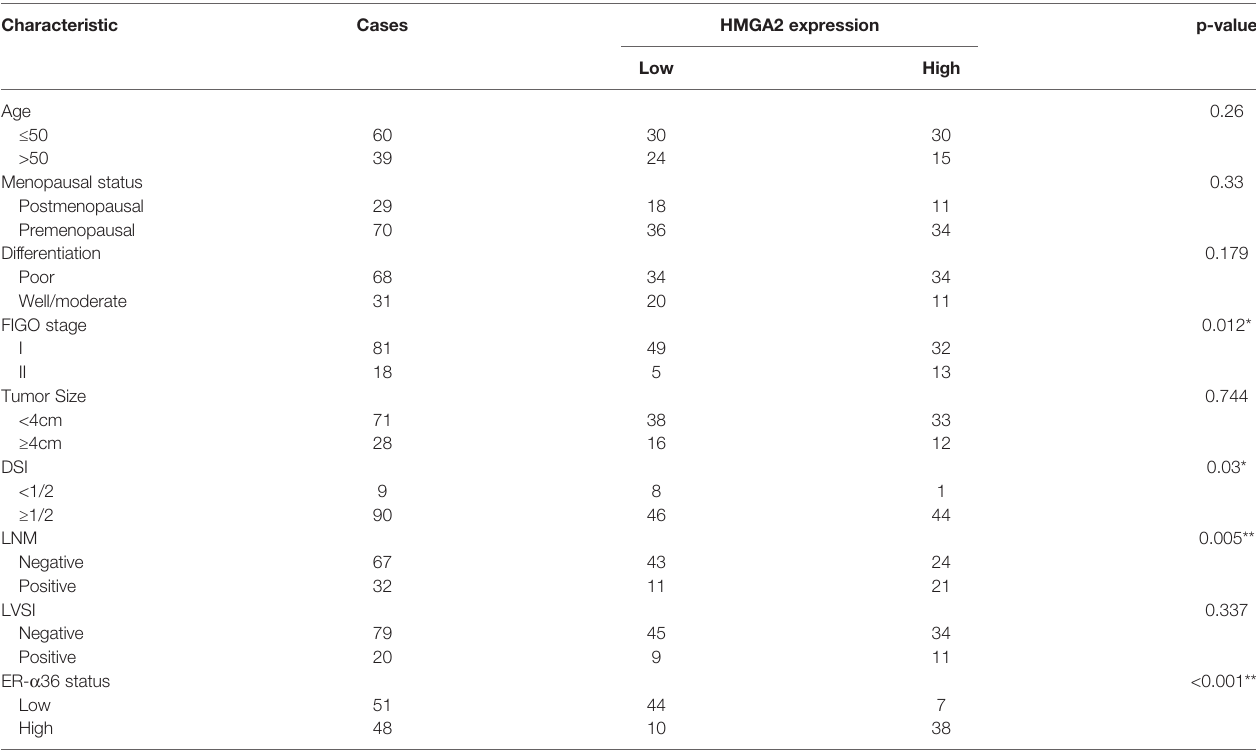
SCC, squamous cell carcinoma; FIGO, International Federation of Gynecology and Obstetrics; DSI, deep stromal invasion; LNM, lymph node metastasis; LVSI, lymphvascular space